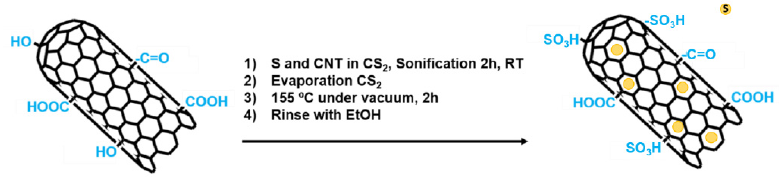
Figure 4. Schematic representation of the CNT functionalization with elemental sulfur.